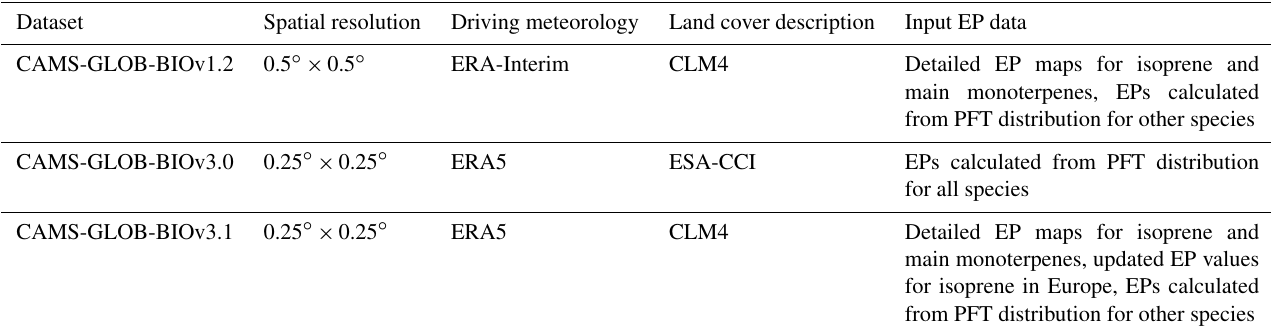
Table 4. Summary of CAMS-GLOB-BIO inventories. Description of horizontal spatial resolution, meteorology driving each dataset, land cover description and emission potential (EP) data used in each inventory.